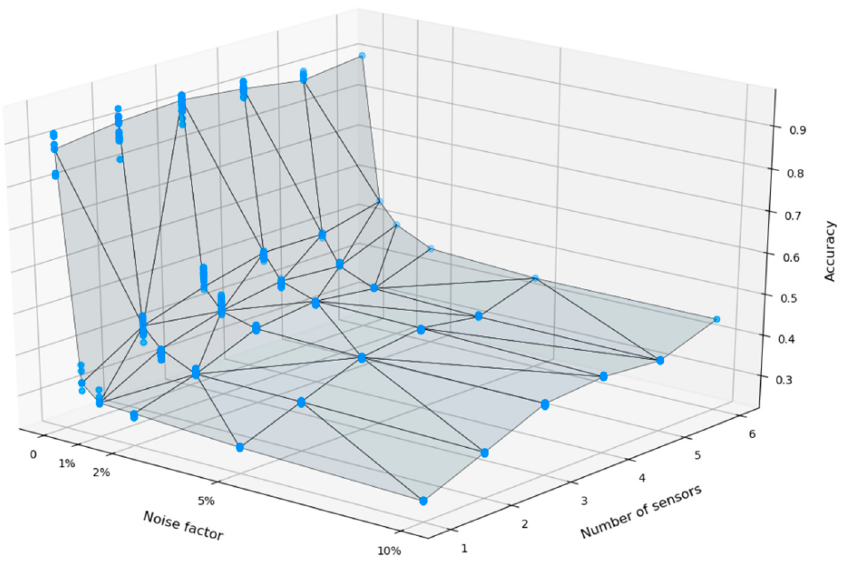
Figure 8. Tnet1 accurate leak location prediction as a function of the noise factor and the number of sensors—3D.